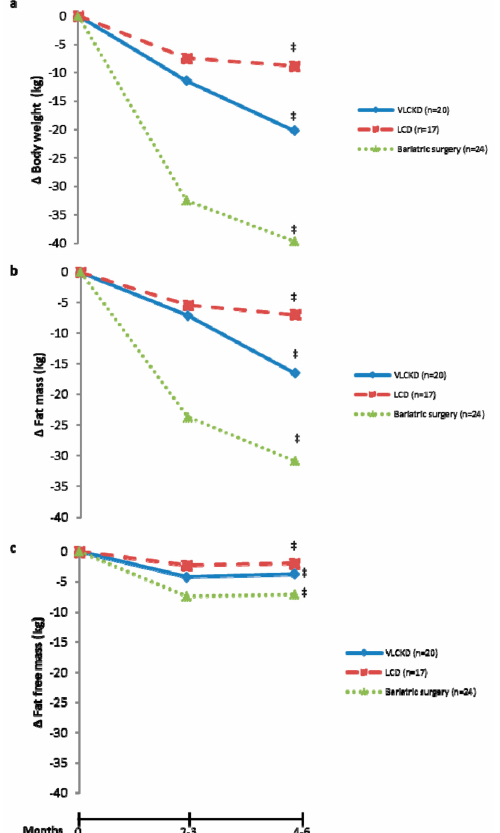
Figure 1. E ff ect of the weight-loss therapies on body weight and body composition during a follow-up period of 4–6 months. Data show di ff erences compared to baseline for body weight ( a ), fat mass ( b ) and fat-free mass ( c ) after a very-low calorie ketogenic diet (VLCKD), a low-calorie diet (LCD) or bariatric surgery. Data are shown as mean values. ‡ Statistically significant ( p < 0.05) changes across time calculated with repeated-measures